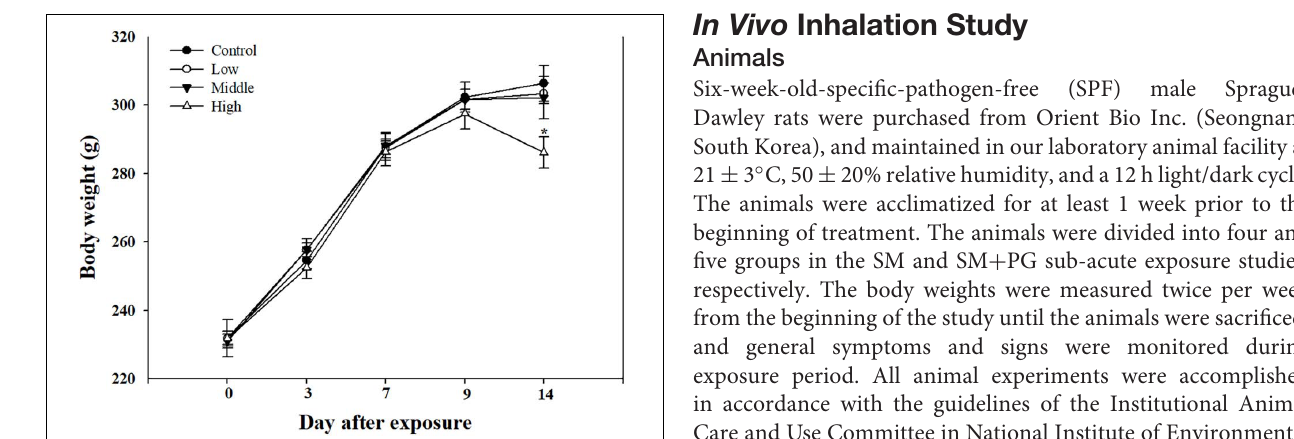
(31.25–1000 µ g/ml). After 7 days of incubation, the medium was removed, the plates were then gently washed with PBS, fixed with methanol for 10 min on ice, and stained with 0.5% crystal violet.